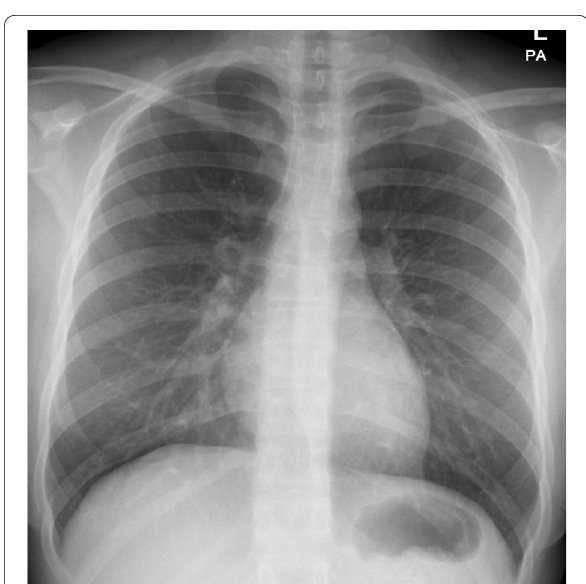
Fig. 2 A 17-year-old girl with COVID-19 pneumonia based on positive RT-PCR test who presented with cough and rhinorrhea for 2 days. Frontal chest radiograph shows no radiographic abnormality. The patient’s serum biochemical parameters show a mildly